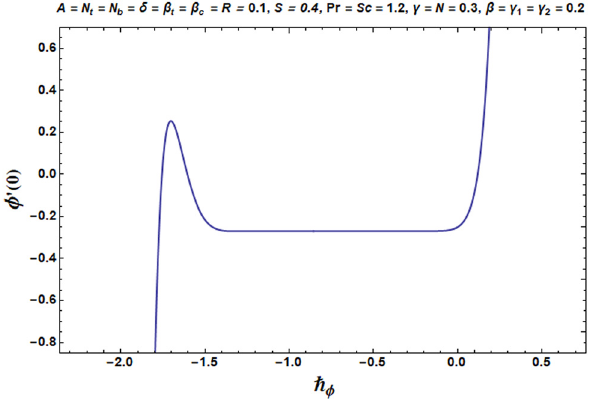
Figure 4: H curve stimulus for ϕ ′ 0 ( ) .